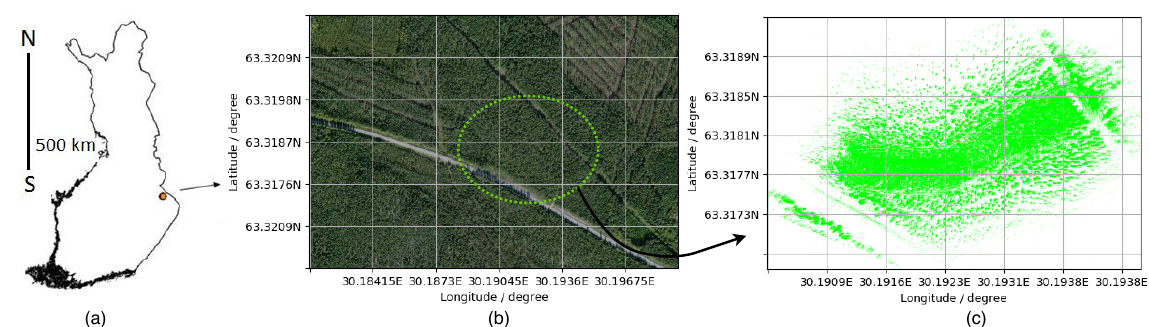
Figure 1. ( a ) The test site in Lieksa, Eastern Finland. ( b ) The forest canopy map from Google maps. ( c ) Point cloud map of the study